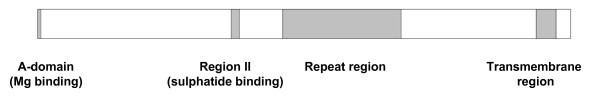
Schematic of a TRAP gene showing relevant domains.